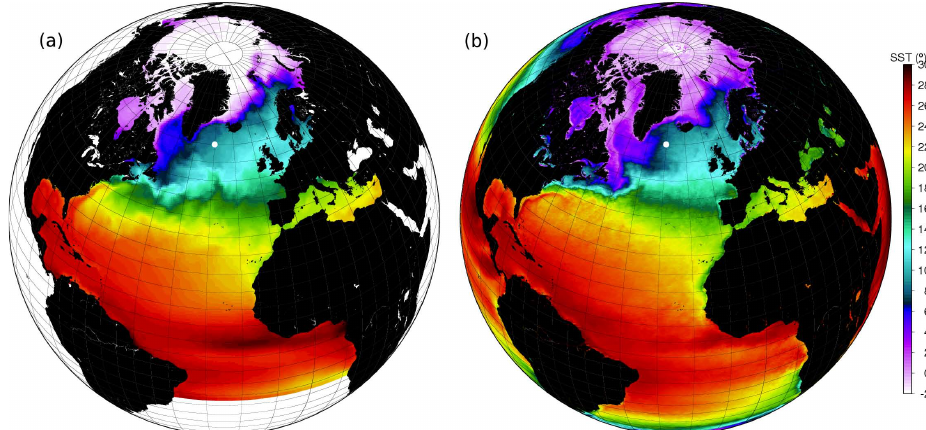
Fig. A1. Maps of GPOMZ (a) and MODIS Aqua (b) annual mean SST for 2009. Figure A1a shows the geographic domain of GPOMZ, with two open boundaries: one across the subtropical South Atlantic at 16.7 ◦ S and one across the Bering Strait in the Pacific sector of the Arctic Ocean. The satellite SST in Fig. A1b is included for comparison, showing that the model provides a realistic representation of all surface fronts. Regions with SST less than zero are partially to fully ice covered.